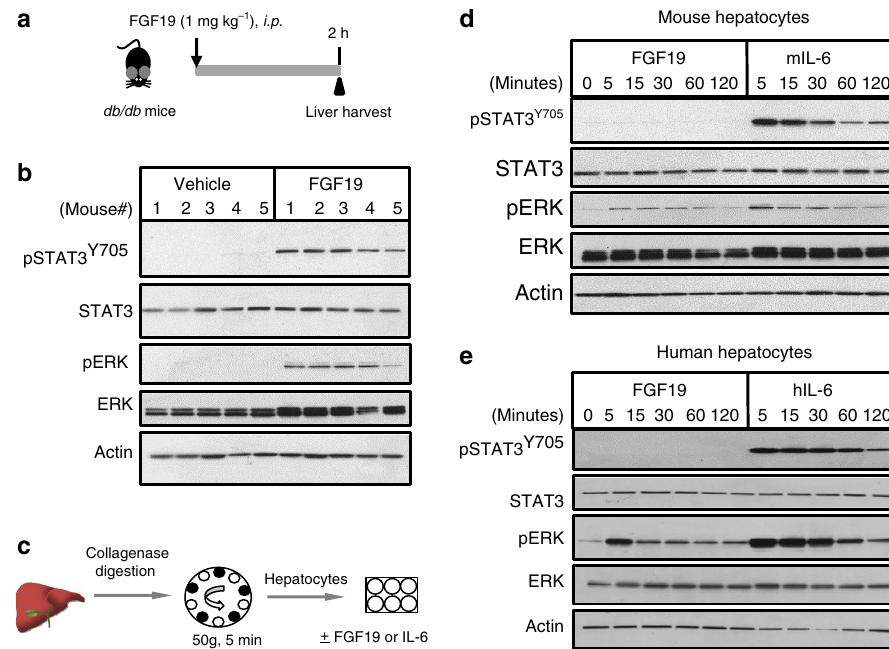
Figure 3 | Non-cell-autonomous activation of hepatocellular STAT3 by FGF19. ( a ) in vivo study design. 11–12-week old db/db mice received a single intraperitoneal injection of 1mgkg (cid:3) 1 FGF19 or vehicle (saline), and livers were harvested 2h post dose ( n ¼ 5 per group). ( b ) Immunoblot analysis of pSTAT3 Y705 in liver lysates of db/db mice treated with recombinant FGF19 protein. Anti-total-STAT3 and anti- b -actin serve as loading control. pERK and total ERK levels were also determined. ( c ) Primary hepatocytes were isolated by collagenase digestion followed by low-speed centrifugation and plating onto collagen-coated plates. ( d ) Lack of pSTAT3 Y705 activation in primary mouse hepatocytes by FGF19. Cell lysates were prepared at the indicated time points following FGF19 stimulation and analysed for phosphorylation of the various proteins. Mouse IL-6 (mIL-6) was included as a positive control. ( e ) Lack of pSTAT3 Y705 activation by FGF19 in primary human hepatocytes. Human IL-6 (hIL-6) was included as a positive